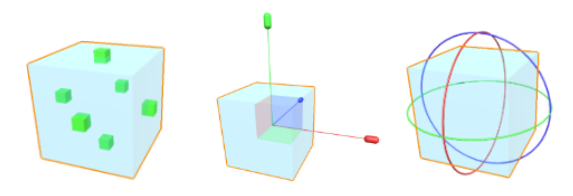
Figure 6: Gizmos for the scale, position, and rotation tools re-